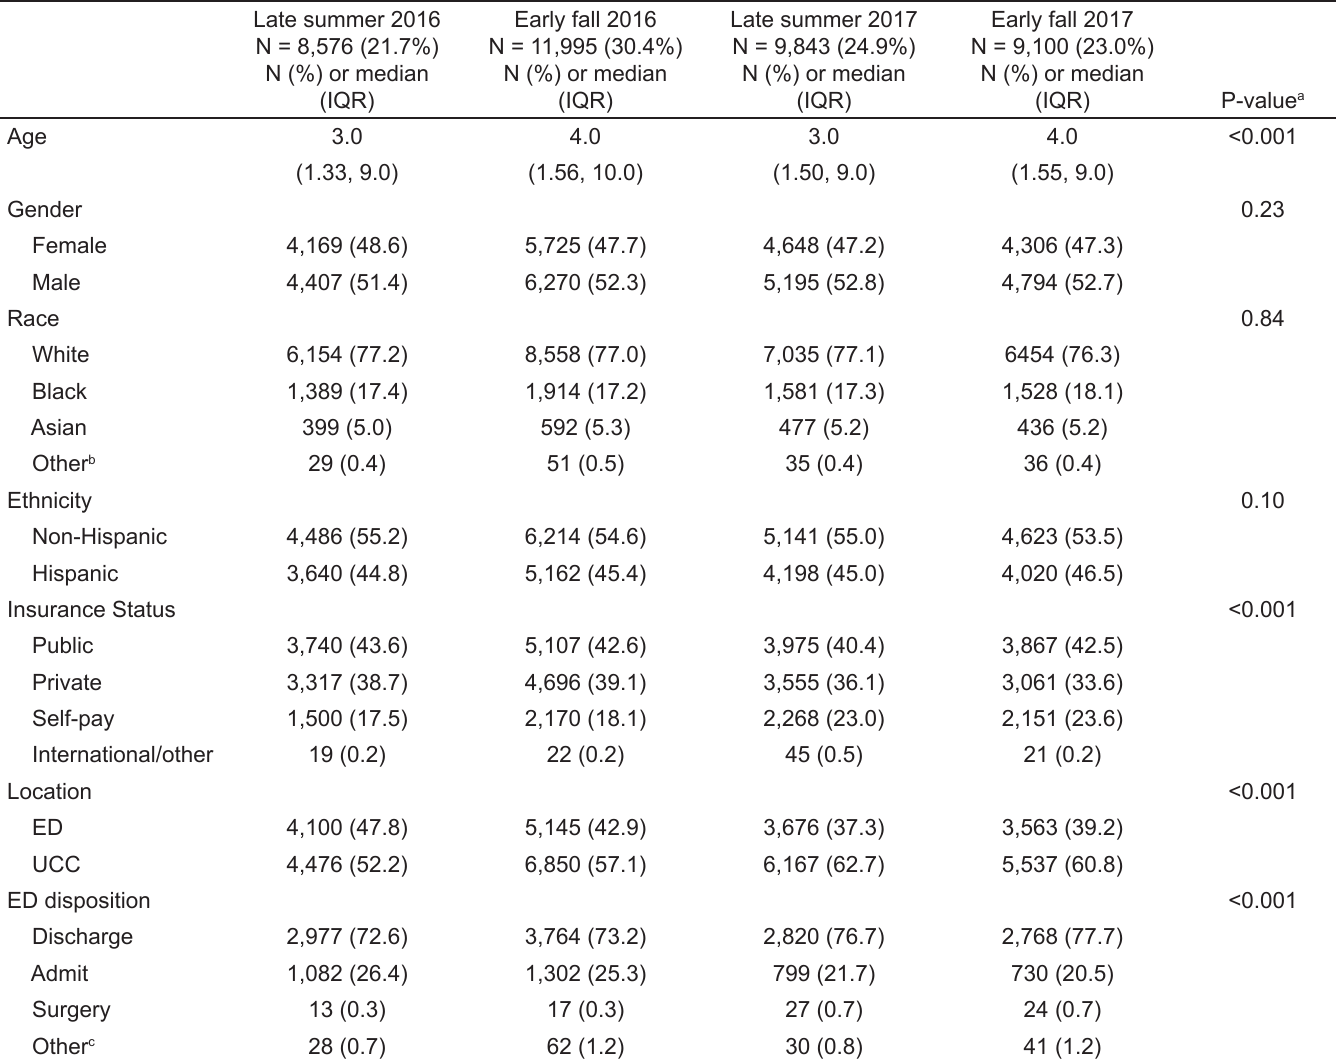
Table. Patient demographics in 2016 and 2017, before and after Hurricane Harvey which made landfall on August 25, 2017 (n = 39,514 patient